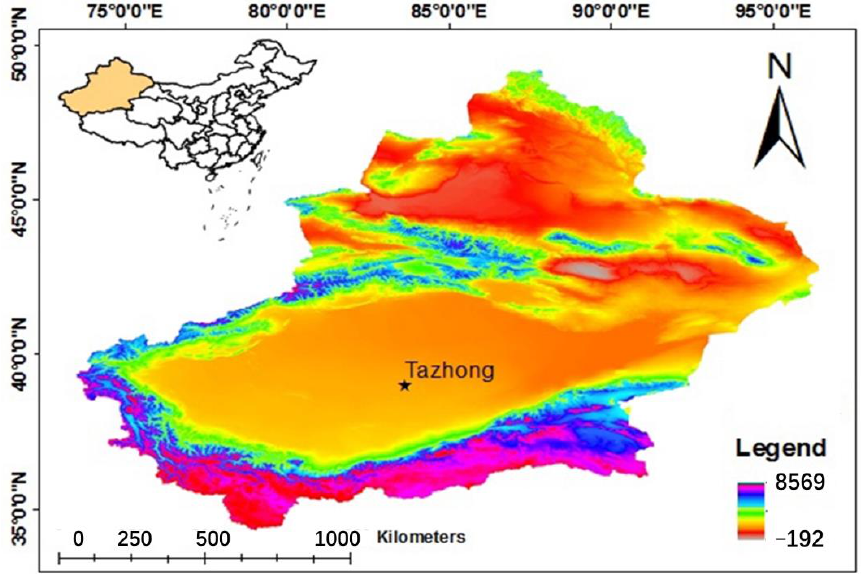
Figure 1. Map of the study area, showing the location of the Tazhong site in the Taklimakan Desert of Xinjiang Province, China.